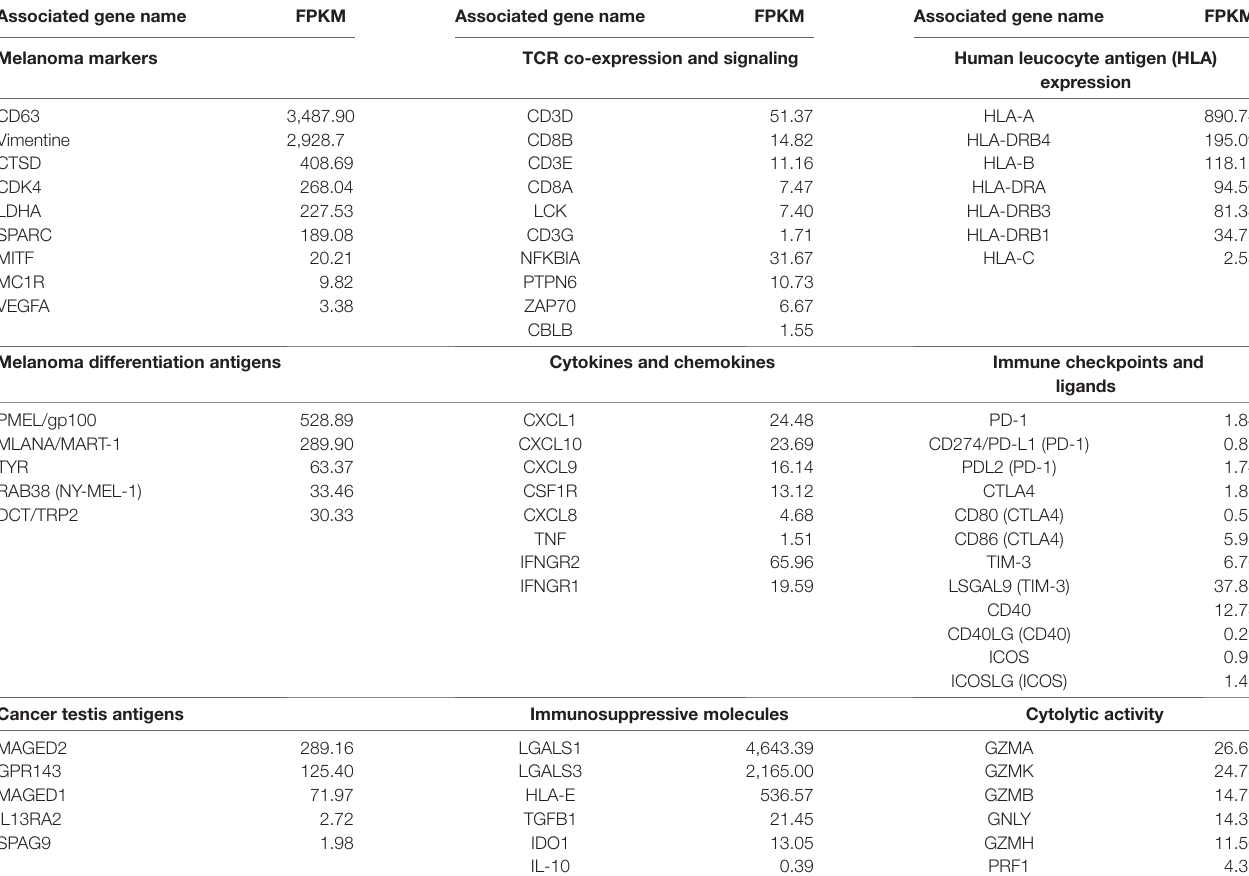
taBLe 1 | Abundance of selected immune-related transcripts from subcutaneous metastasis from patient